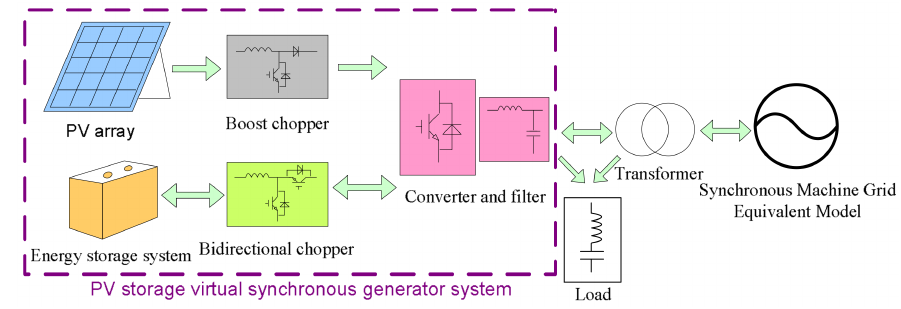
Figure 17. Simulation model structure